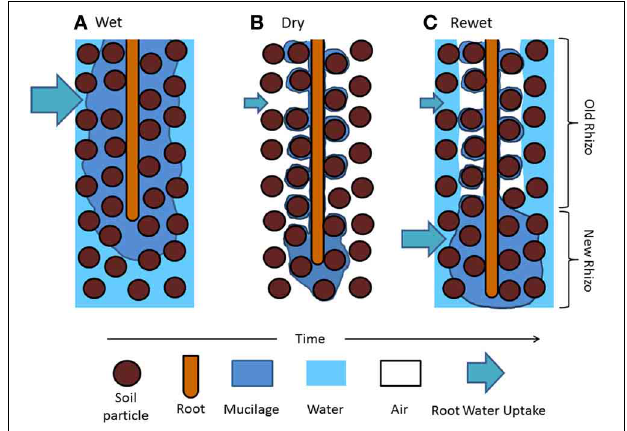
FIGURE 1 | Hypothetical distribution of mucilage and water in the rhizosphere during a drying and wetting cycle. (A) Mucilage is exuded at the root tips and diffuses through the soil matrix. (B) As roots take up water and the soil becomes dry, mucilage dehydrates and shrinks around the root and the soil particle near the root (the rhizosphere ). As the soil dries and mucilage becomes old, mucilage becomes water repellent and stiff. (C) After irrigation, old mucilage rewets slowly and the rhizosphere remains temporarily dry, possibly limiting the local water uptake. Freshly exuded mucilage covering the root tip is expected to rewet quickly. Water uptake might increase at the root apical segments.